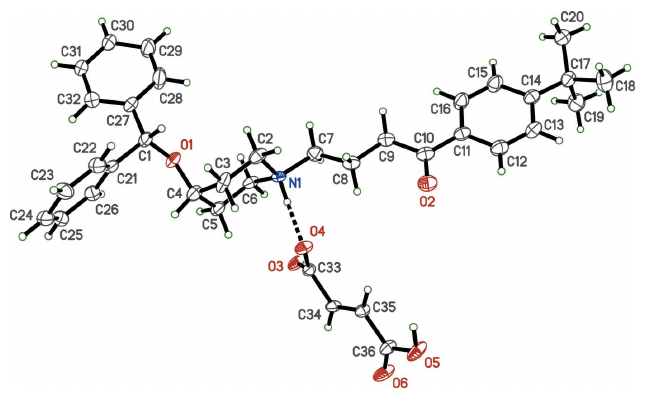
Figure 2 A ball-and-stick plot showing the superposition of major (solid bonds) and minor (open bonds) in ebastinium hydrogen fumarate, I . Hydrogen atoms (except for piperidinium NH) are omitted to enhance